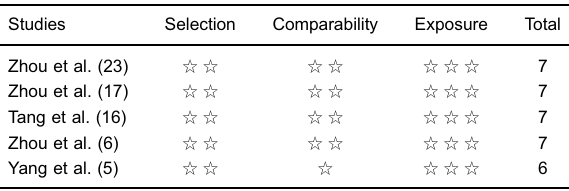
Table 2. Risk of bias of case-control studies according to Newcastle-Ottawa Scale. Studies